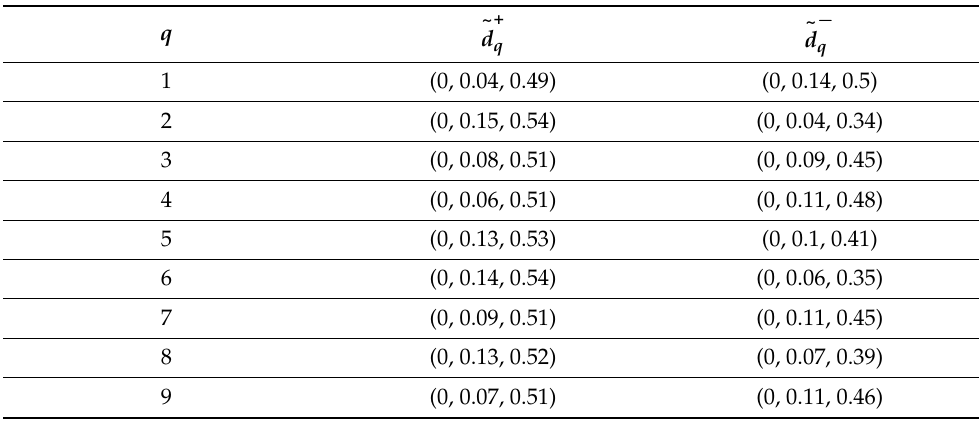
Table A4. Distances between each smart technology application and the two reference